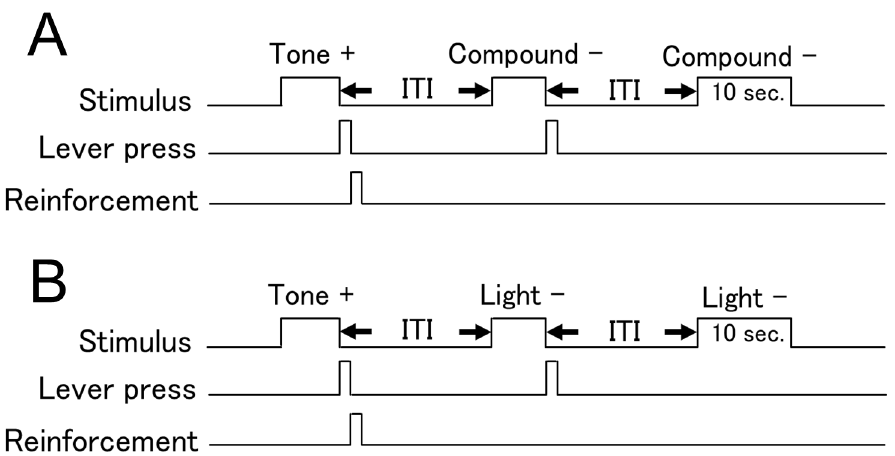
Figure 1. Negative patterning and simple discrimination paradigms. In the negative patterning task, lever presses were reinforced following either of the stimulus elements (Tone +, Light +), but not following the compound stimulus (Compound -; panel A). In the simple discrimination task, for 1 group, lever responses were rewarded when the tone stimulus was presented (Tone +), but not when the light stimulus was presented (Light -; panel B). For the other group, the relationship between cue modality and availability of reinforcement was reversed (Light +, Tone